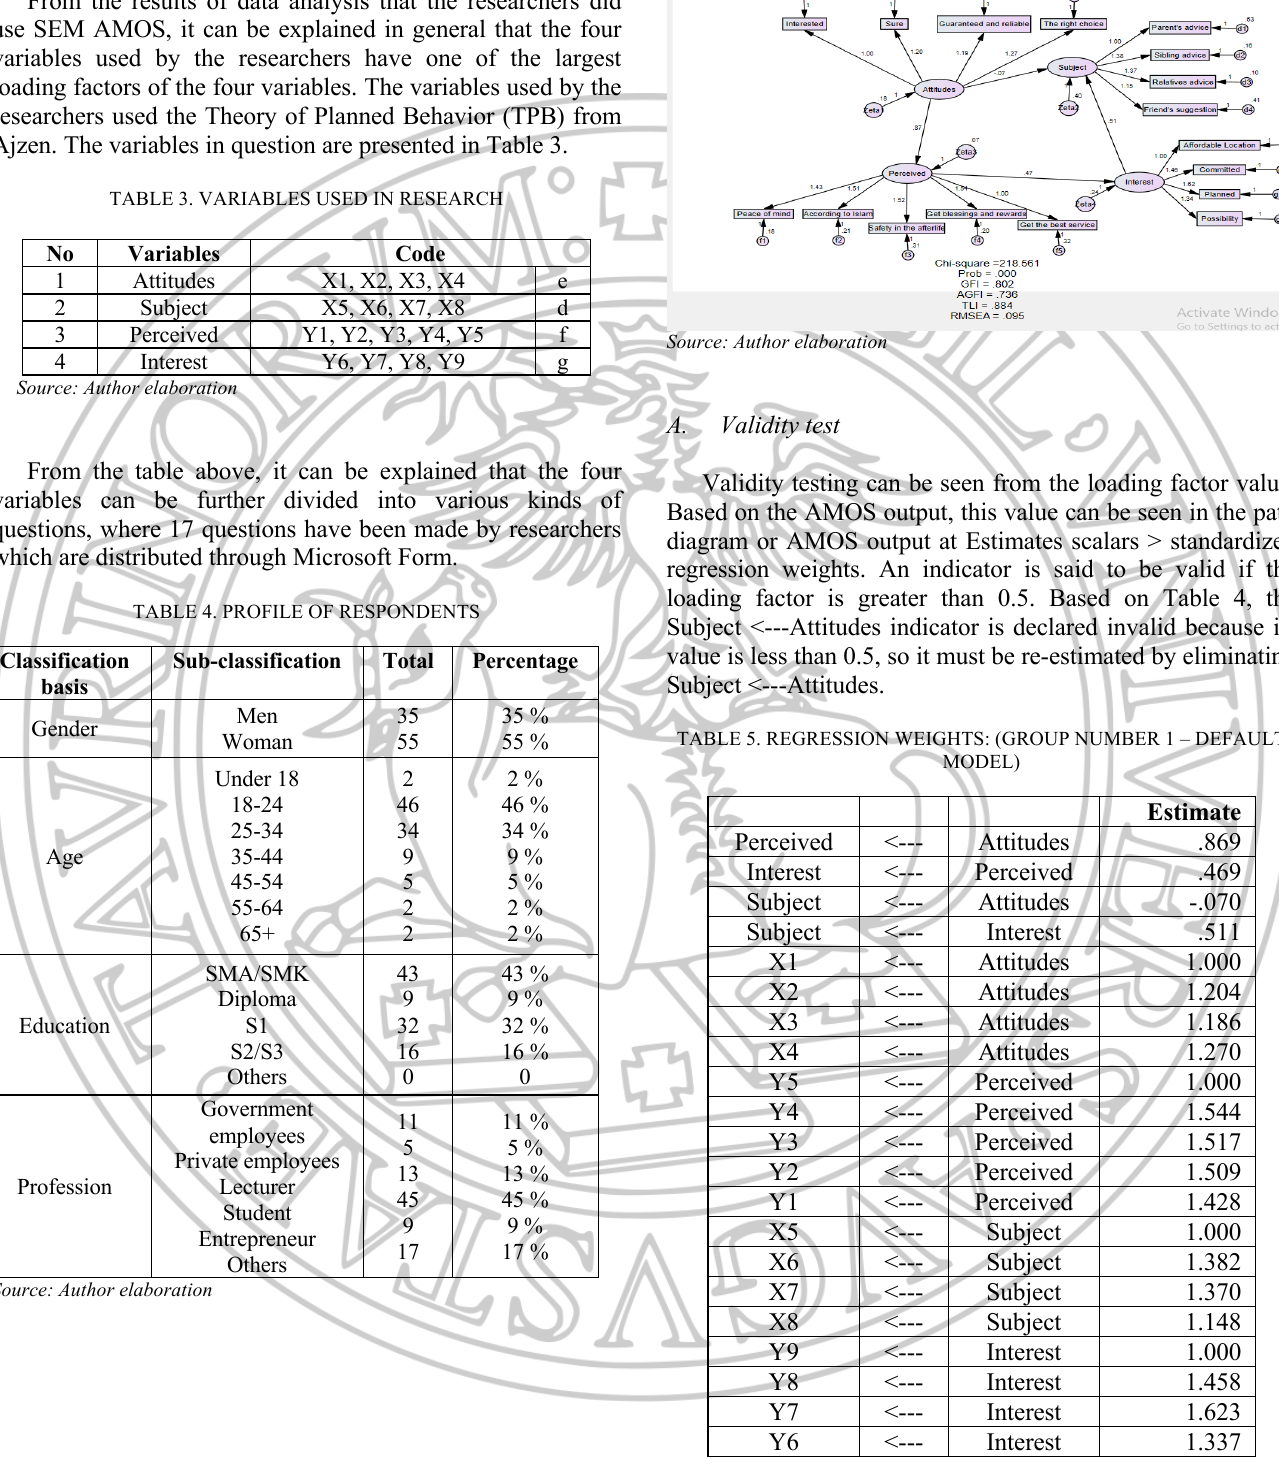
TABLE 3. VARIABLES USED IN RESEARCH